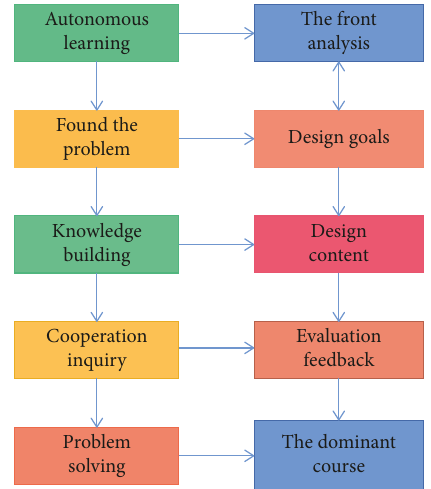
Figure 5: Deep teaching mode based on Cloud Class.